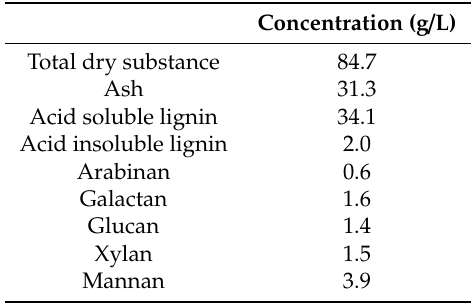
Table 1. Composition of the spent-sulfite-liquor (SSL) raw